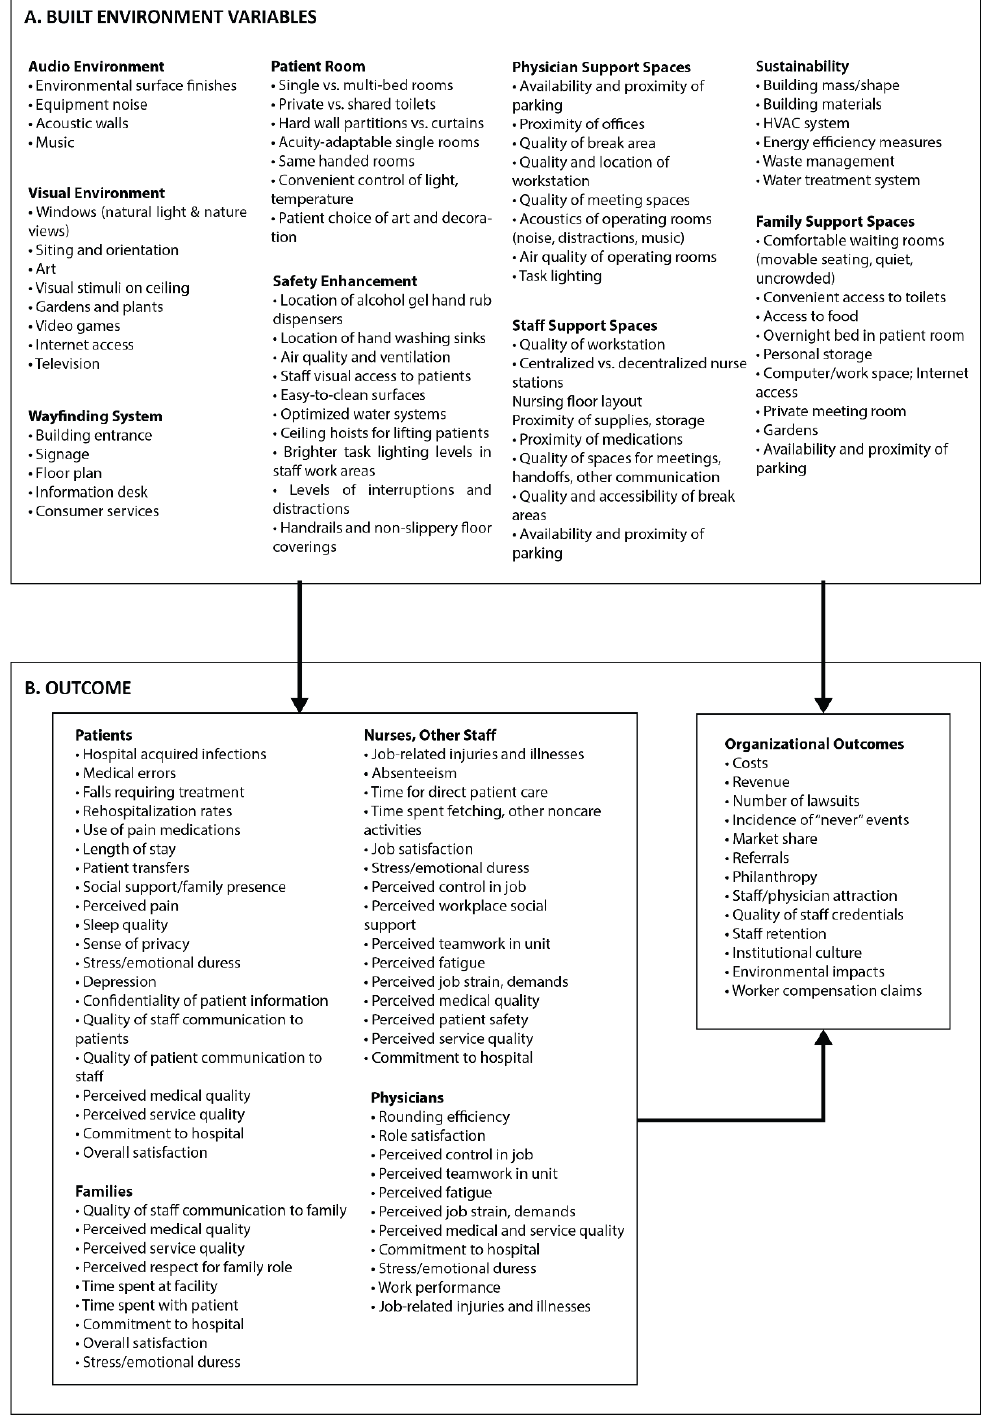
Figure 2. The Evidence-Based Design theoretical framework. Elaborated by the authors starting from Ulrich studies [18].